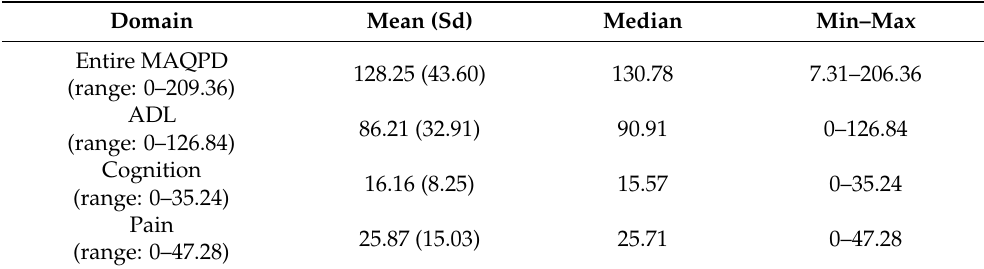
Table 3. Descriptive analysis of MAQPD scores.